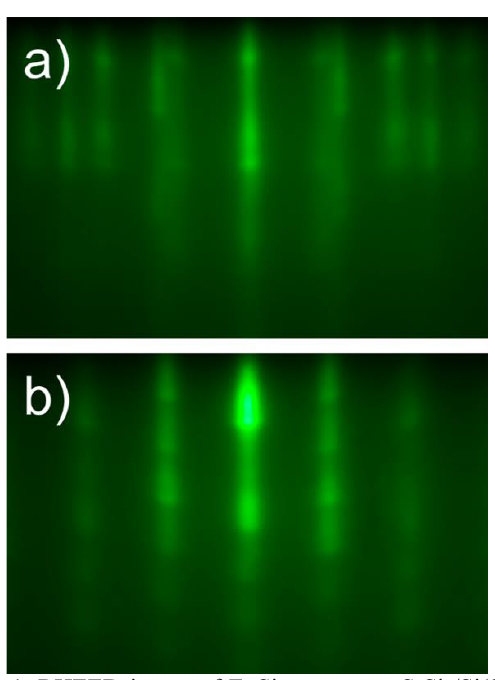
Fig. 1. RHEED image of EuSi 2 grown on SrSi 2 /Si(001) viewed along azimuth [110] of the substrate. a) thickness less than 7 nm; b) thickness exceeds 7 nm.